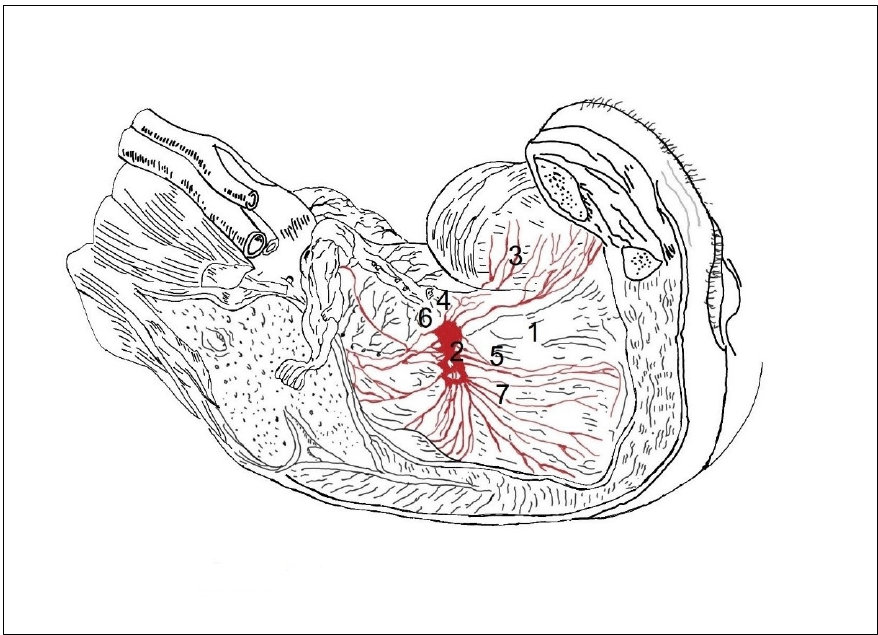
Figure 5. In the concentric type, 1 to 2 large-sized ganglia (2) are observed, from which arise separated branches (almost unconnected nerves on the periphery) to the outer surface of the vagina (1), to the urinary bladder (3), ureter (4), vagina (5), uterus (6), and rectum